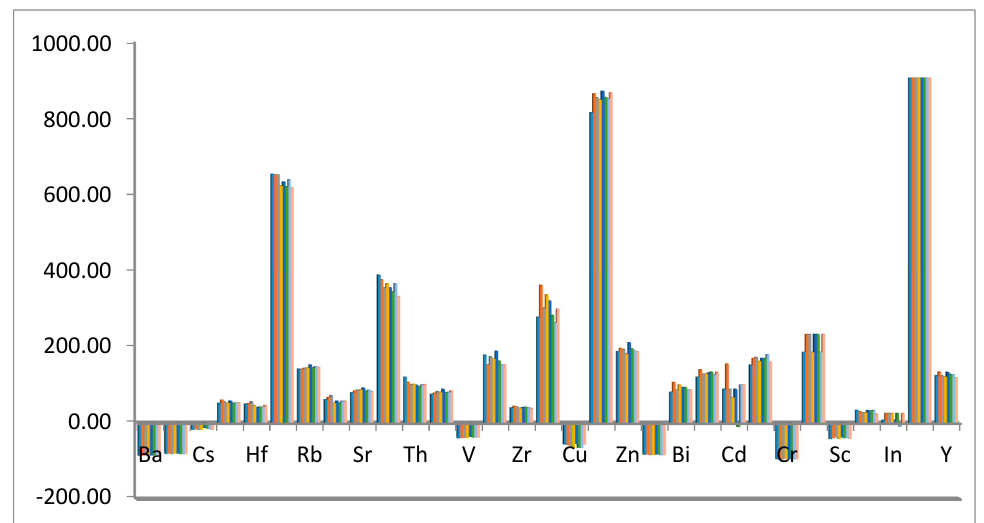
Figure 4. Depletion-enrichment variation diagram of trace elements in the studied altered granites.